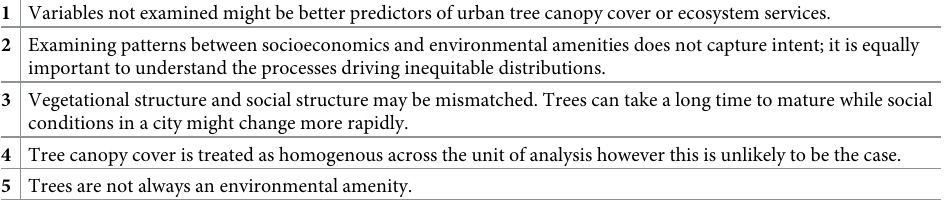
Table 2. Caveats to consider when carrying out or interpreting results from urban tree canopy cover distribu- tional equity studies. Reproduced with modifications from Schwarz et al. (2015), with permission from K.